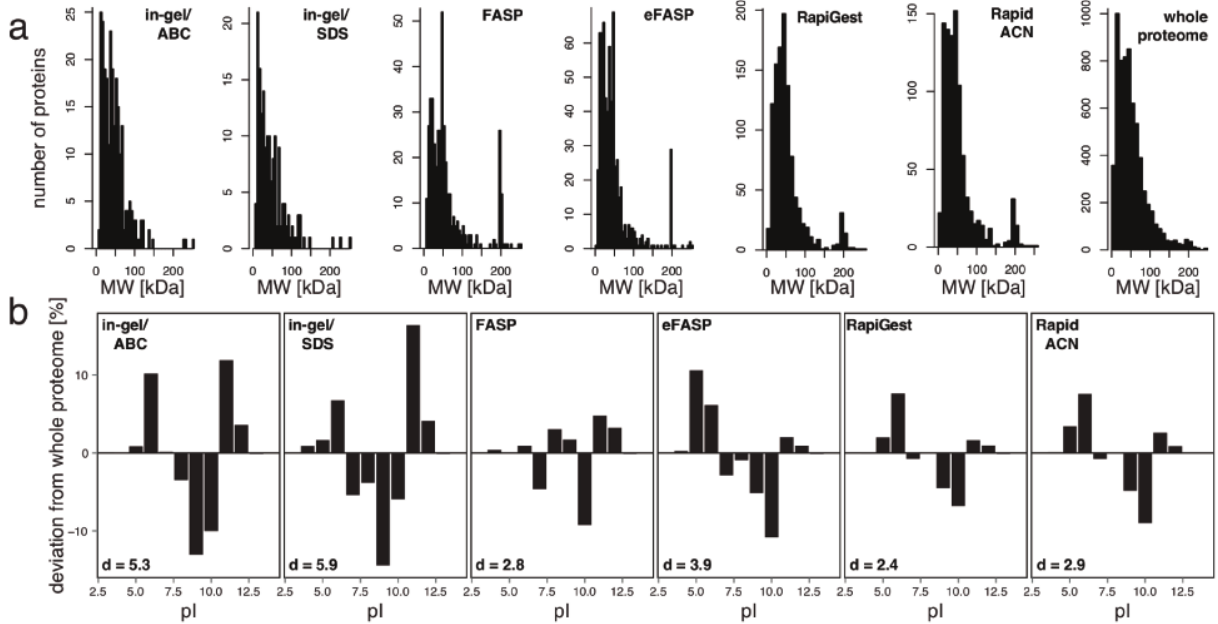
Figure S1. Bias of protein size and pI in sample preparation. ( a ) The spectrum of protein sizes is well covered for all protocols examined. The number of identified proteins was plotted against the theoretical molecular weight (MW) for each protocol investigated. Although some protocols yielded higher identifications than others, the MW range was highly reproducible for all of them when comparing against the whole yeast proteome. ( b ) Different representations of protein charges. When comparing to the distribution of theoretical protein pI values of the whole proteome, all investigated protocols showed an under-representation of proteins with a pI of 10. When expressing the total deviation as deviation score d, RapiGest, FASP and RapidACN score best. The d values were calculated as the sum of all differences in % compared to the theoretical proteome occurrence multiplied by